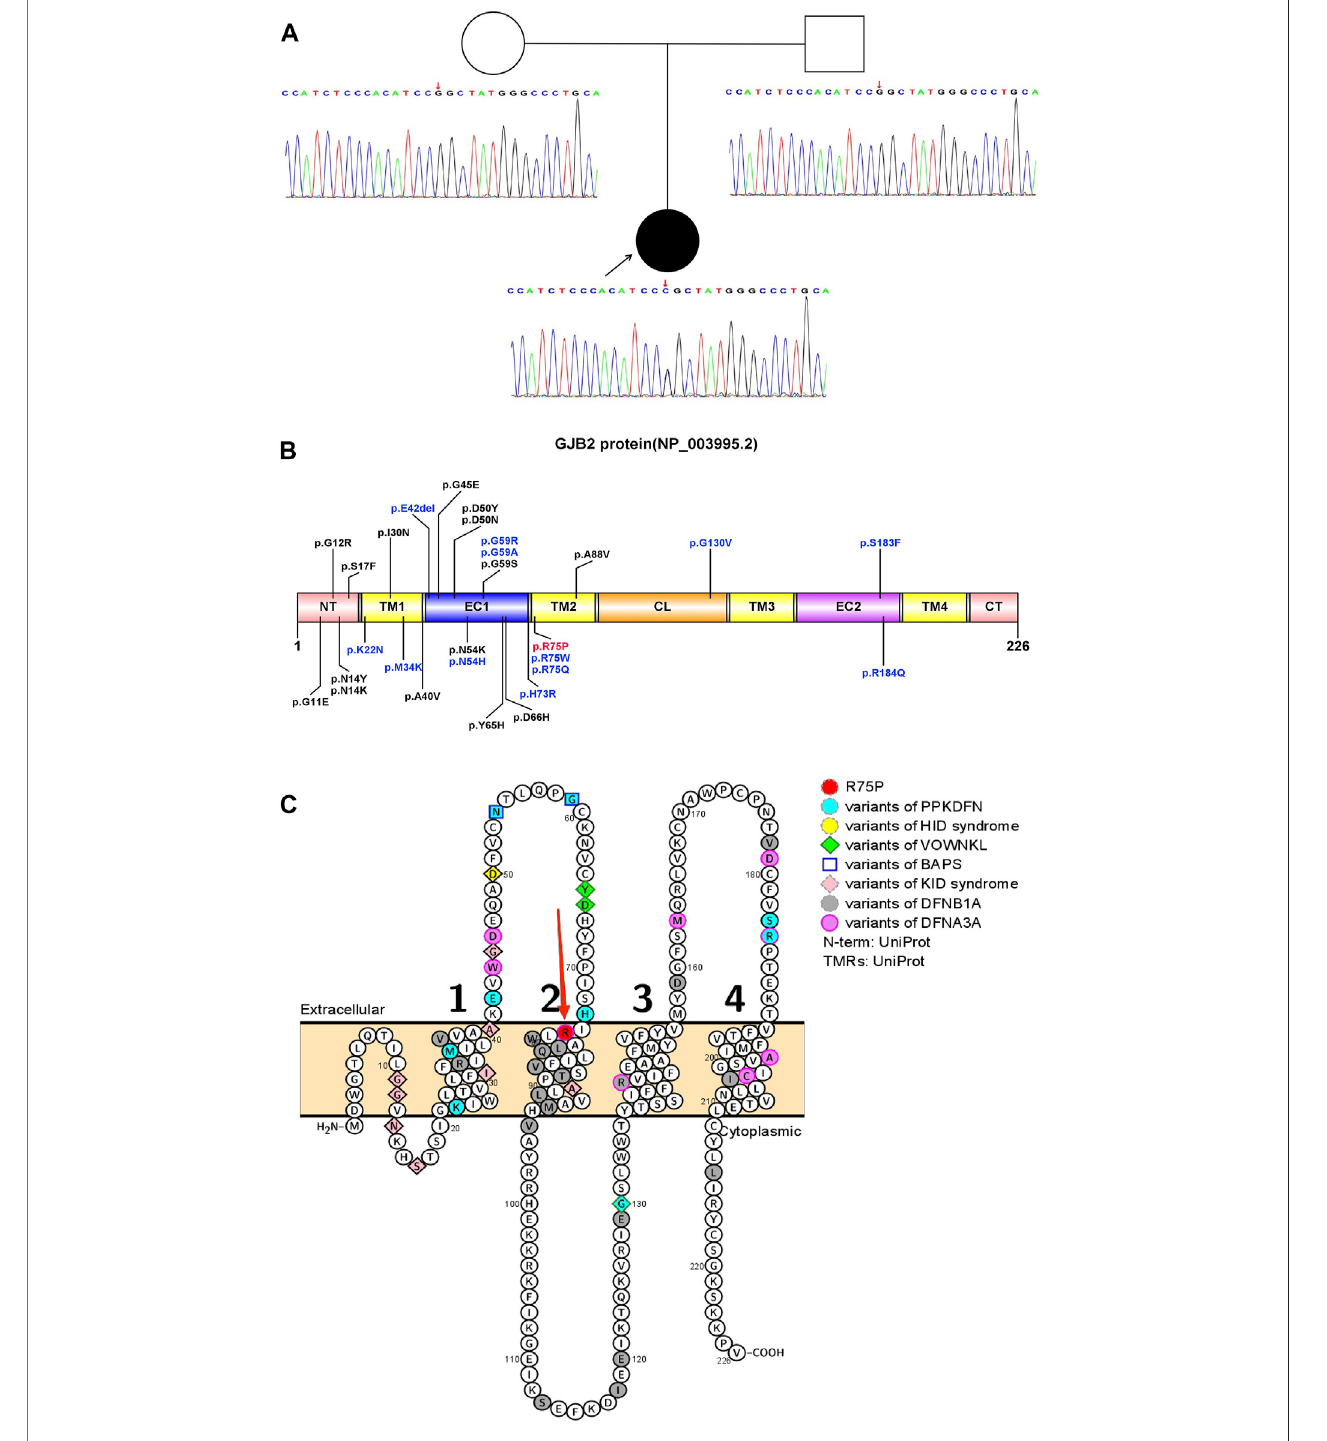
FIGURE 1 | Pattern diagram of the GJB2 protein domain, protein functional region, and transmembrane domain analysis. (A) Pedigree and Sanger sequence of GJB2 c.224intheprobandandparents.Anovelheterozygousmissensevariantin GJB2 c.224G > CwasdetectedintheprobandsufferingfromPPKDFN,butneitherthe father nor the mother of the proband was detected for the same. (B) Currently reported variant sites that cause PPKDFN (blue font) and other SHL (black font), and the variantsiteinthisstudy(redfont). (C) Locationsofreportedpathogenic GJB2 variants(variantpositionsindifferentdiseasesarerepresentedbydifferentcolorsand shapes). Labels of TMs are represented by 1, 2, 3, and 4 (black numbers).The p.R75P variant site (red arrow) is at the junction of EC1 and TM2.